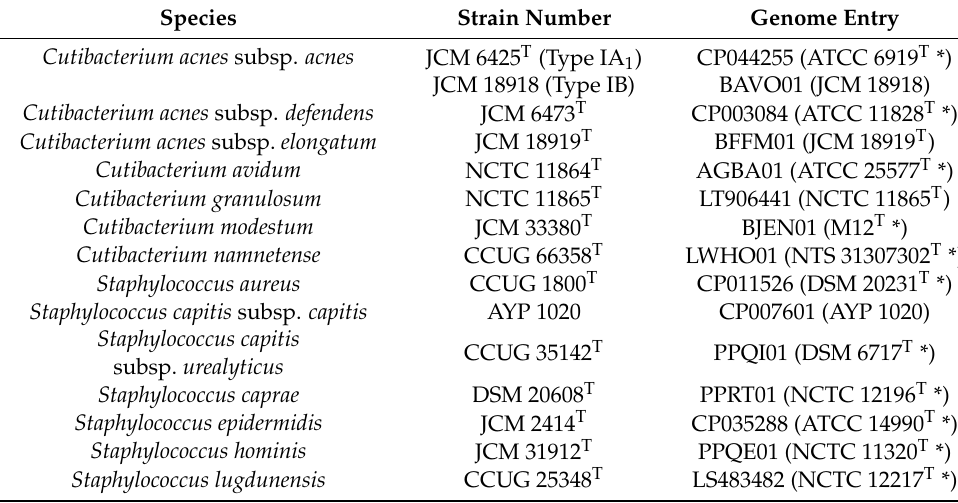
Table 1. Strains used. T after strain number indicates type strains of species/subspecies. * Identical to the used strain (same strain deposited from different culture collections). Species Strain